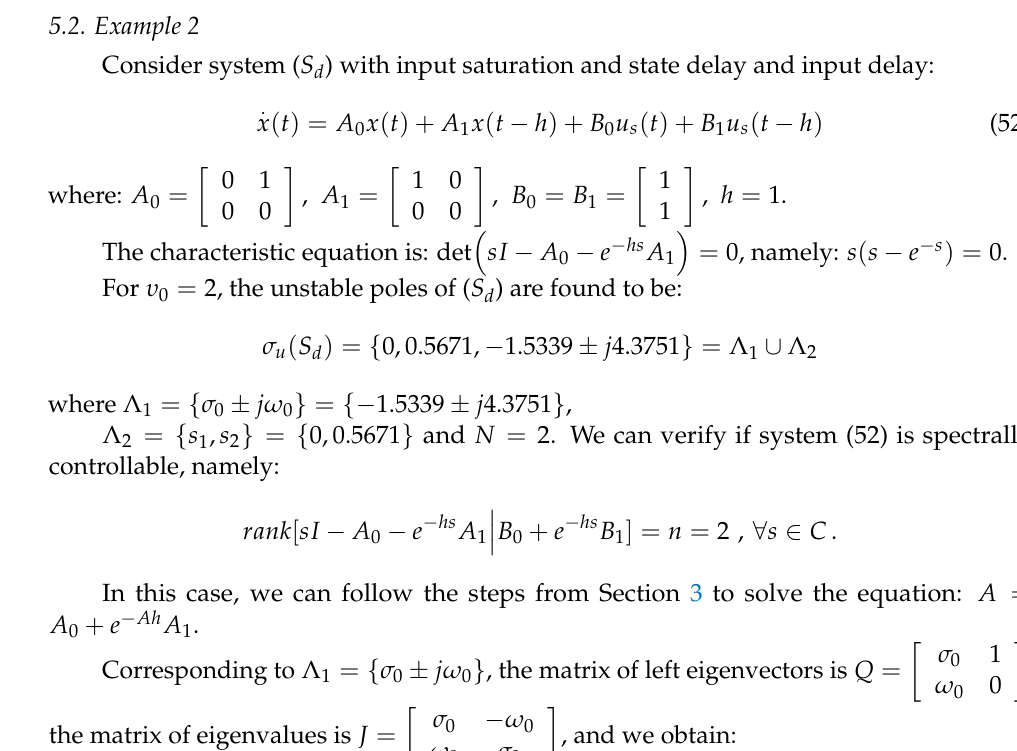
≤ u . Figure 3. Evolution of the states with | u | ≤